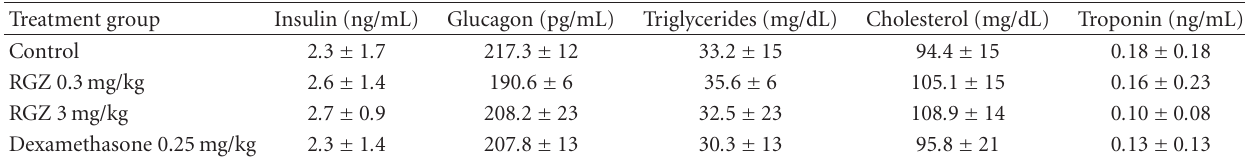
Table 1: Insulin, glucagon, lipids, and troponin measurements. Plasma samples taken at 20 weeks for metabolic analyses showed there were no significant di ff erences ( P > 0 . 05) in insulin, glucagon, lipids, and troponin measurements in RGZ- and dexamethasone-treated groups compared with controls. Values are mean ± SD. N = 24 (6 in each group).